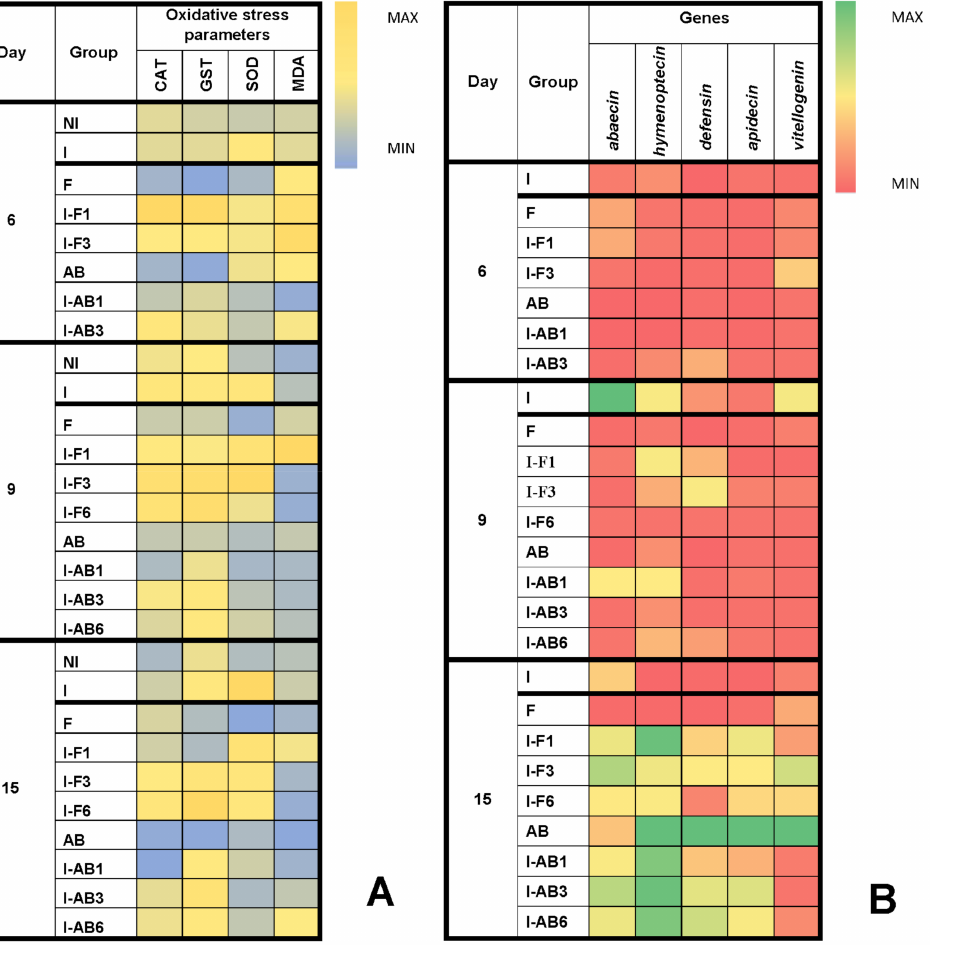
Figure 4. Heatmaps: ( A ) mean values for superoxide dismutase (SOD), catalase (CAT) and glutathione S-transferase (GST) activities and malondialdehyde (MDA) concentration; ( B ) immune-related genes (medians of Log2 of relative expression ratios for abaecin, hymenoptaecin, defensin, apidaecin and vitellogenin ) at different time points in experimental groups. Non- infected control (NI), N. ceranae infected control (I) and groups infected and treated with fumagillin from day 1 (I-F1), day 3 (I-F3) and day 6 (I-F6) or A. blazei extract from day 1 (I-AB1), day 3 (I-AB3) and day 6 (I-AB6). Group names are indicated